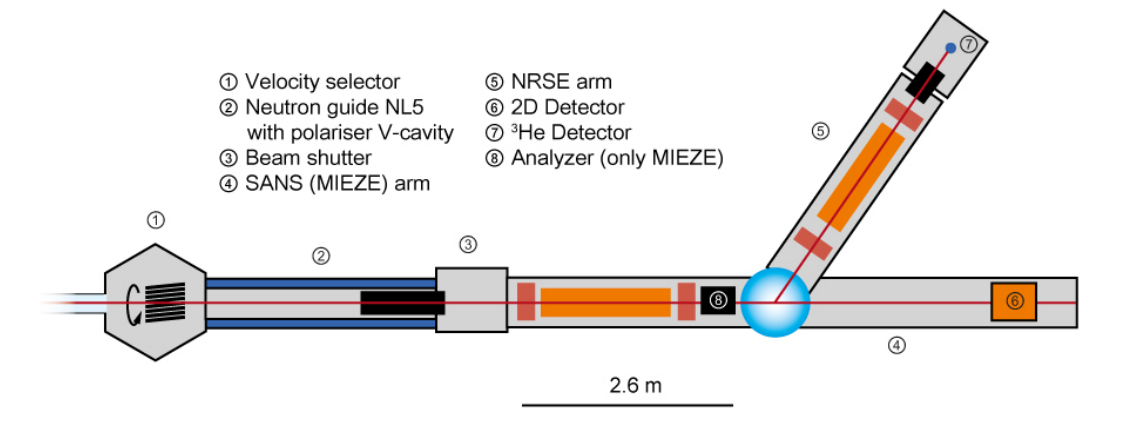
Figure 2: Schematic drawing of